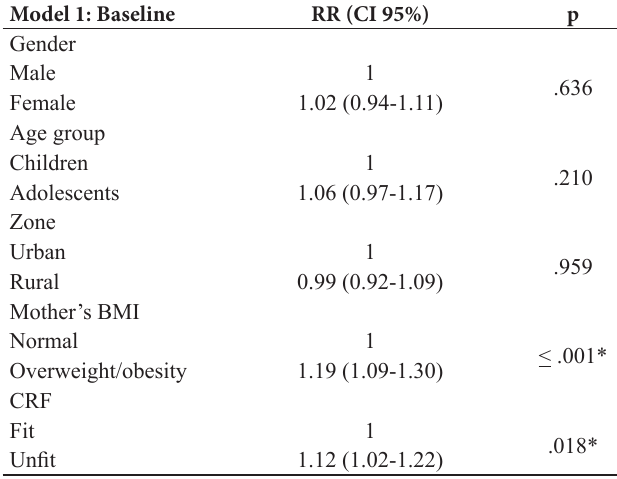
Table 3. Incidence of overweight/obesity and baseline determinant variables. Model 1: